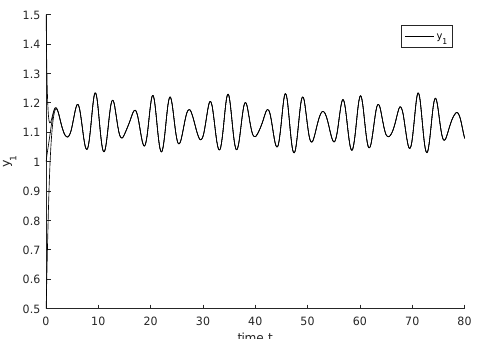
Figure 3: Dynamic behaviors of the solutions y *